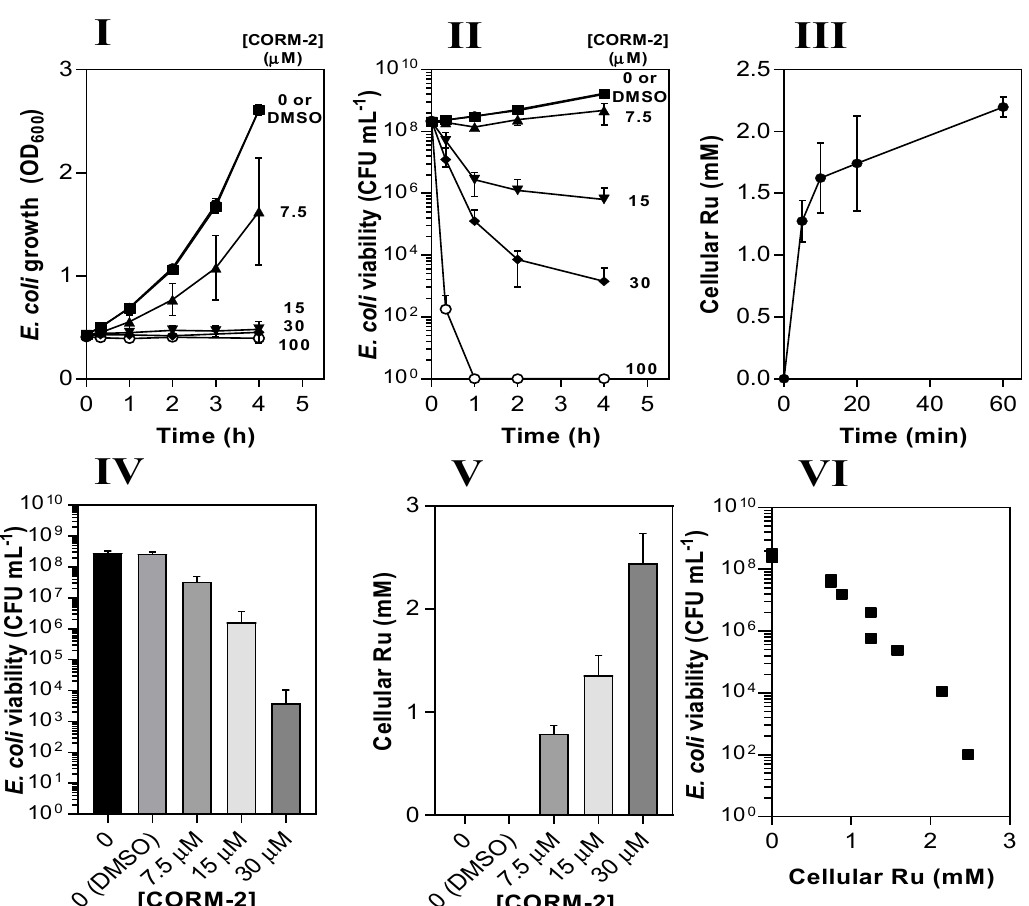
Figure 3. The antimicrobial activity of CORM-2 against E. coli is strongly correlated with intracellular Ru accumulation. The dose-dependent inhibitory effects of CORM-2 (0–100 µ M) on E. coli growth ( I ) and viability ( II ) as determined by measuring optical density (OD 600 ) and colony-forming units (CFU). Uptake of CORM-2 ( III ) was assessed by measuring cellular Ru content at time intervals after addition of 30 µ M CORM to early log-phase E. coli . The viability ( IV ) of E. coli cultures 1 h after addition of 0–30 µ M CORM-2 was compared to the level of intracellular Ru ( V ). The data in IV and V are plotted in VI to show the negative correlation between the culture viability and the extent of Ru accumulation (r 2 = 0.92). Cells were grown on GDMM in all experiments. Cellular Ru content was assessed by conducting ICP-AES on culture samples. Data represent three biological repeats ± standard deviation (SD) and the data in ( VI ) were analysed via a Pearson’s (two-tailed) correlational analysis ( p ≤ 0.0001).